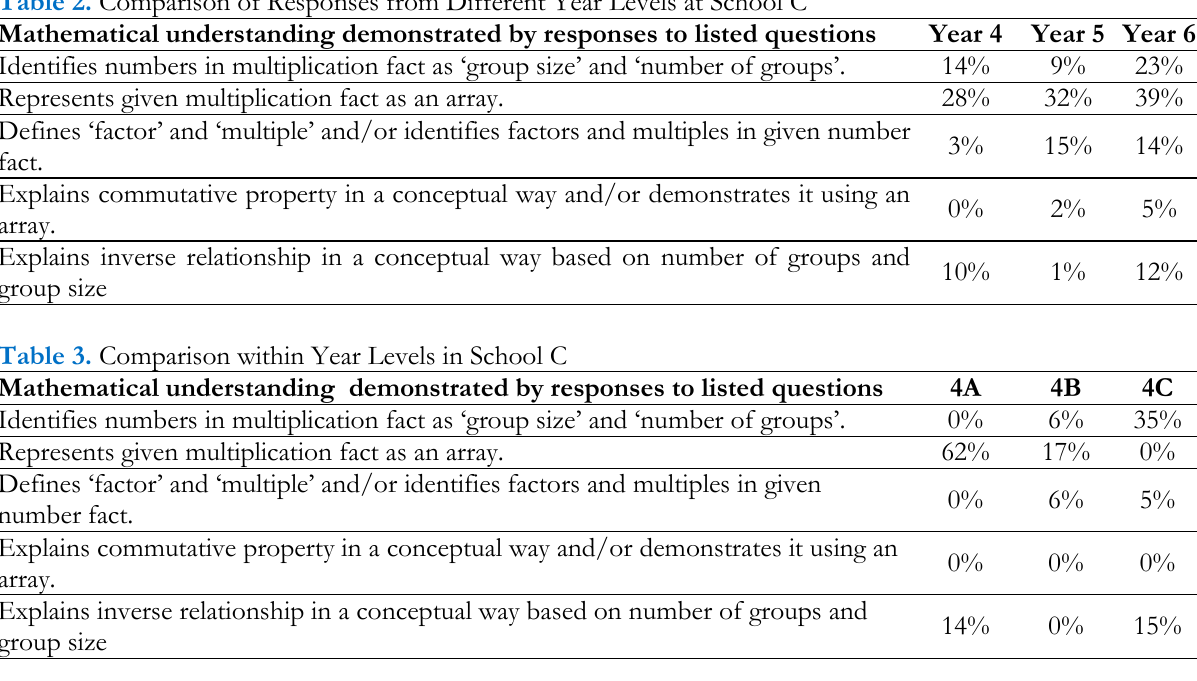
Table 2. Comparison of Responses from Different Year Levels at School C Mathematical understanding demonstrated by responses to listed questions